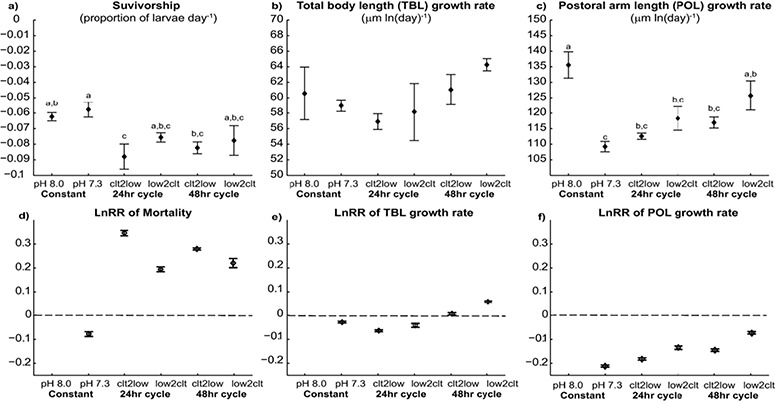
Survivorship (rate of decline in density), total body length and postoral arm length growth rate of larval urchins exposed to constant and fluctuating pH between 8.0 and 7.3. Means and standard errors of means of the three replicate jars per treatment were plotted (N = 18, a–c). Exposure to constant low pH did not significantly increase mortality (pH 7.3 in a) but did compromise the growth rates of arms (pH 7.3 in c). Log response ratio (LnRR) for each treatment relative to the constant pH 8.0 (control) and their corresponding 95% confidence intervals are shown (d–f). The log response ratio relative to constant pH 8.0 (control) affirmed the pattern observed in the direct measurements i.e. increased larval mortality (d) and a significant reduction in arm growth (f) in the acidified treatments. Pairwise comparisons of the LnRR with Z-test showed that the frequency (24- vs 48-h cycle) and the initial condition (clt2low vs low2 clt) can modulate pH impact (d–f). The LnRR and variance of sampling are listed in Table 2.